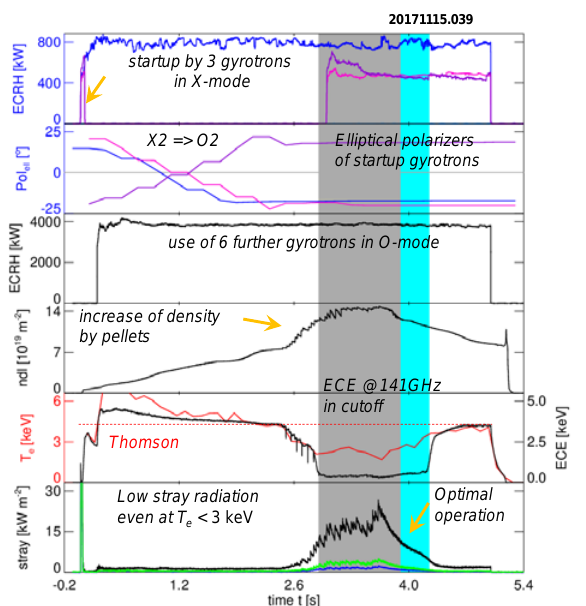
Fig.3: High density plasma scenario with O2- ECRH and pellet injection. The second row shows the chance of polarizer position for the 3 “start-up” gyrotron beams, when their polarisation was switched from X2 to O2. High performance